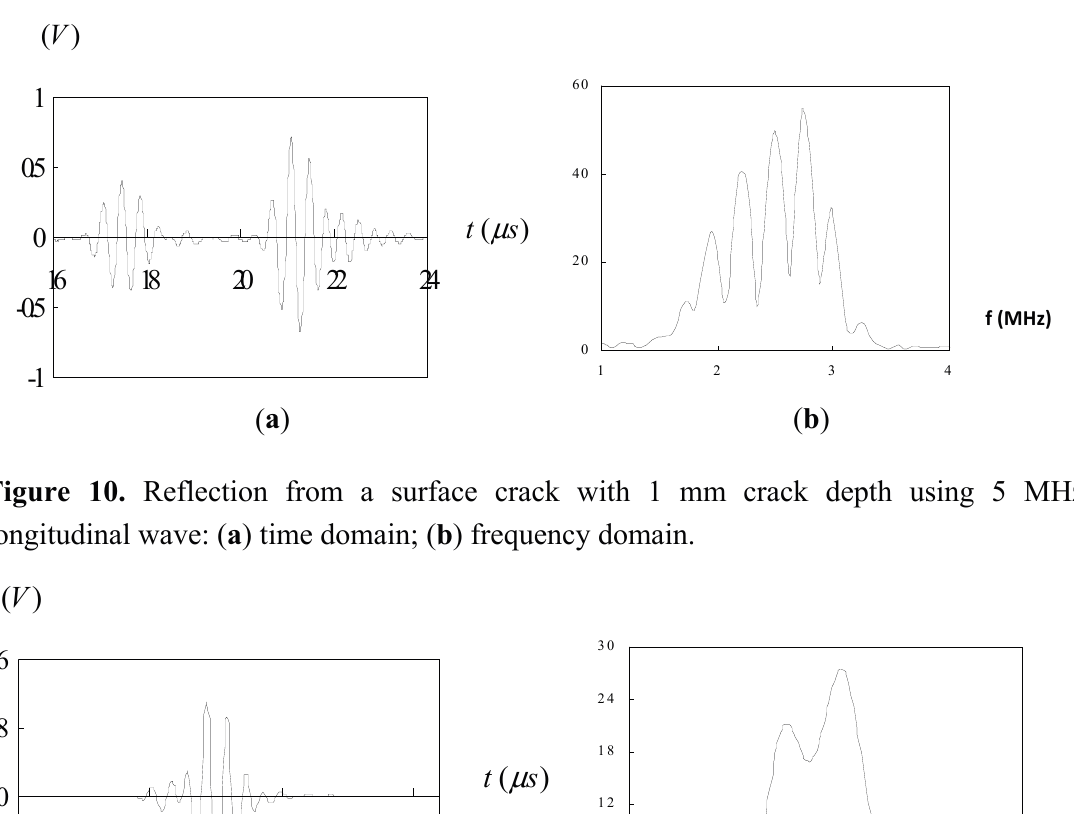
Figure 9. Reflection from a surface crack with 8 mm crack depth using 2.25 MHz longitudinal wave: ( a ) time domain; ( b ) frequency domain.